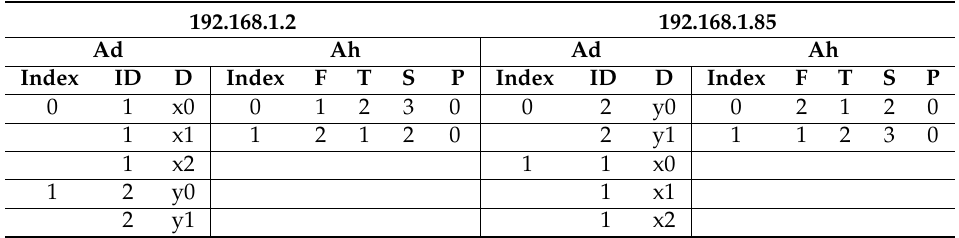
Table 3. Data transference between Ro 1 and Ro 2 .